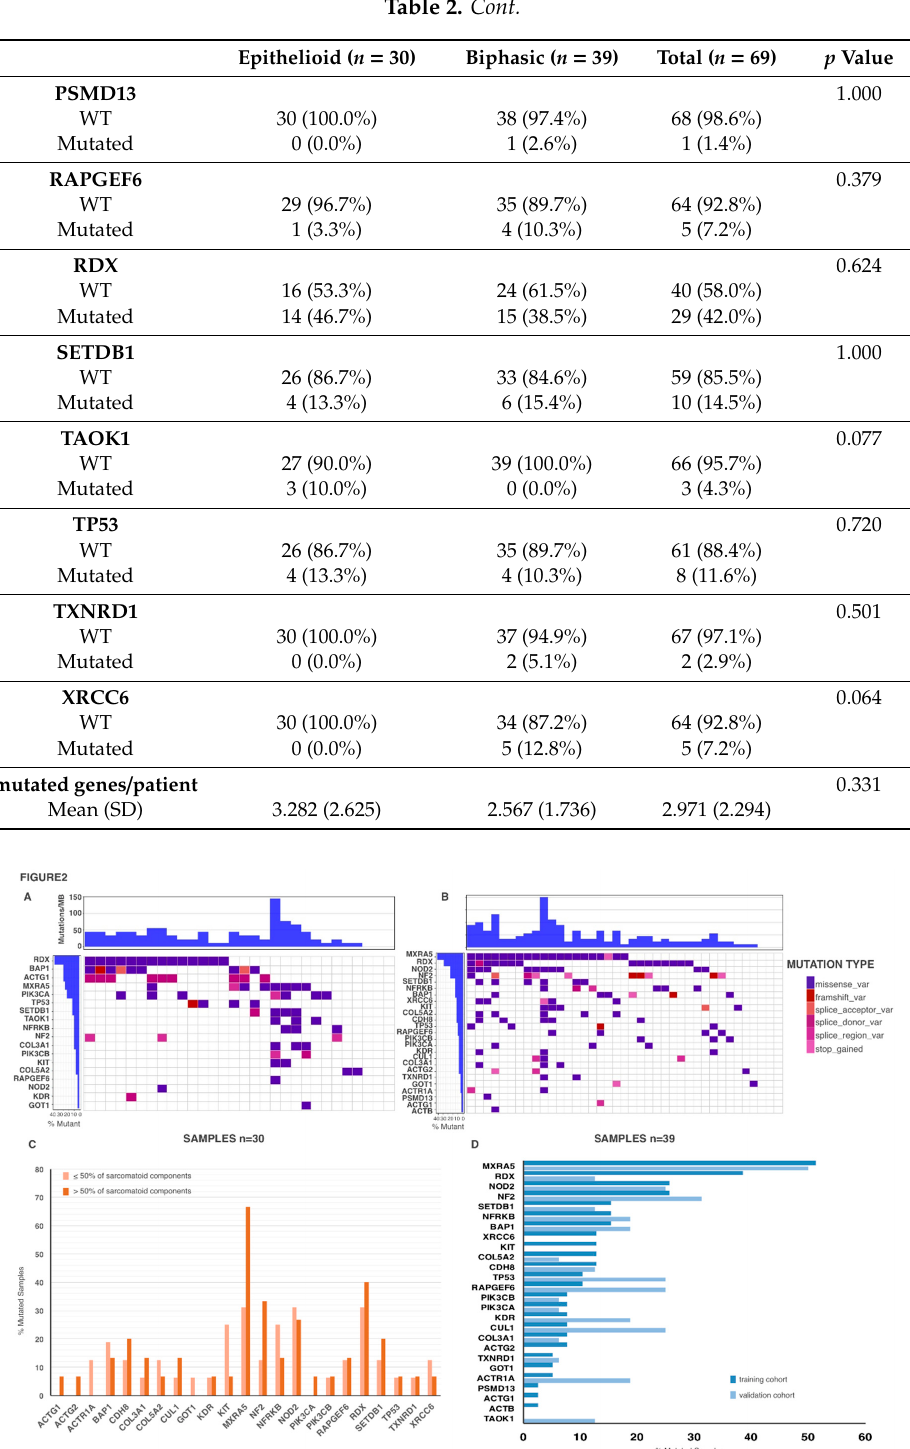
Figure 2. Biph-MPMs have a distinct mutational profile as compared with eMPM ( A ) Waterfall plot representing the gene mutations occurred in each patient with epithelioid MPM (columns). ( B ) Waterfall plot representing the gene mutations occurred in each patient with biphasic MPM (columns). Squares of di ff erent colors indicate di ff erent mutation types. Upper histograms represent the estimated number of mutations per Megabase for each patient. ( C ) Comparison of mutated genes frequencies between biphasic MPMs with di ff erent percentage of sarcomatoid component. ( D ) Comparison of frequencies of the principal mutated genes in biphasic MPM between training and validation